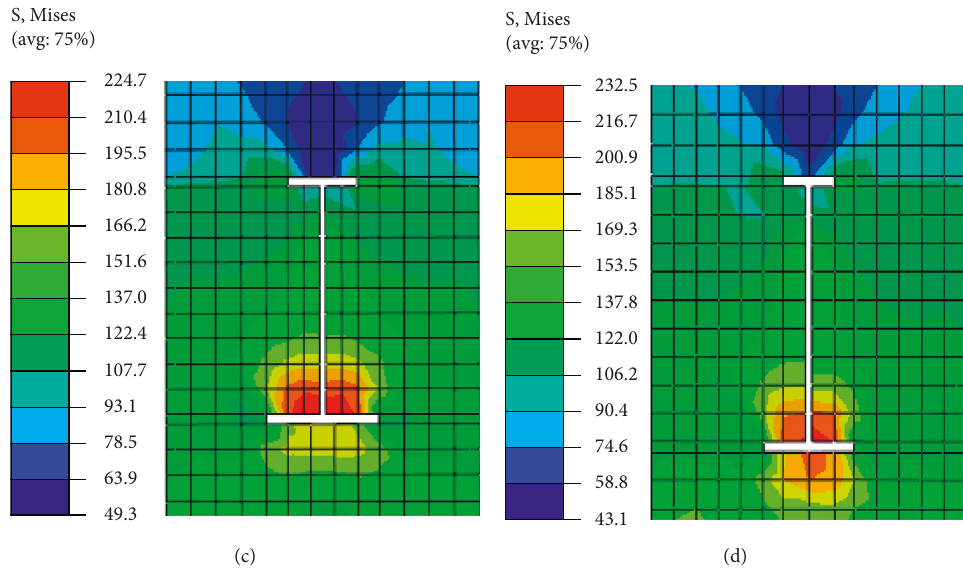
Figure 11: Stress cloud diagram for the tube (the maximum strength moment, unit in MPa): (a) CFCJ1; (b) CFCJ2; (c) CFCJ3; (d) CFCJ4.